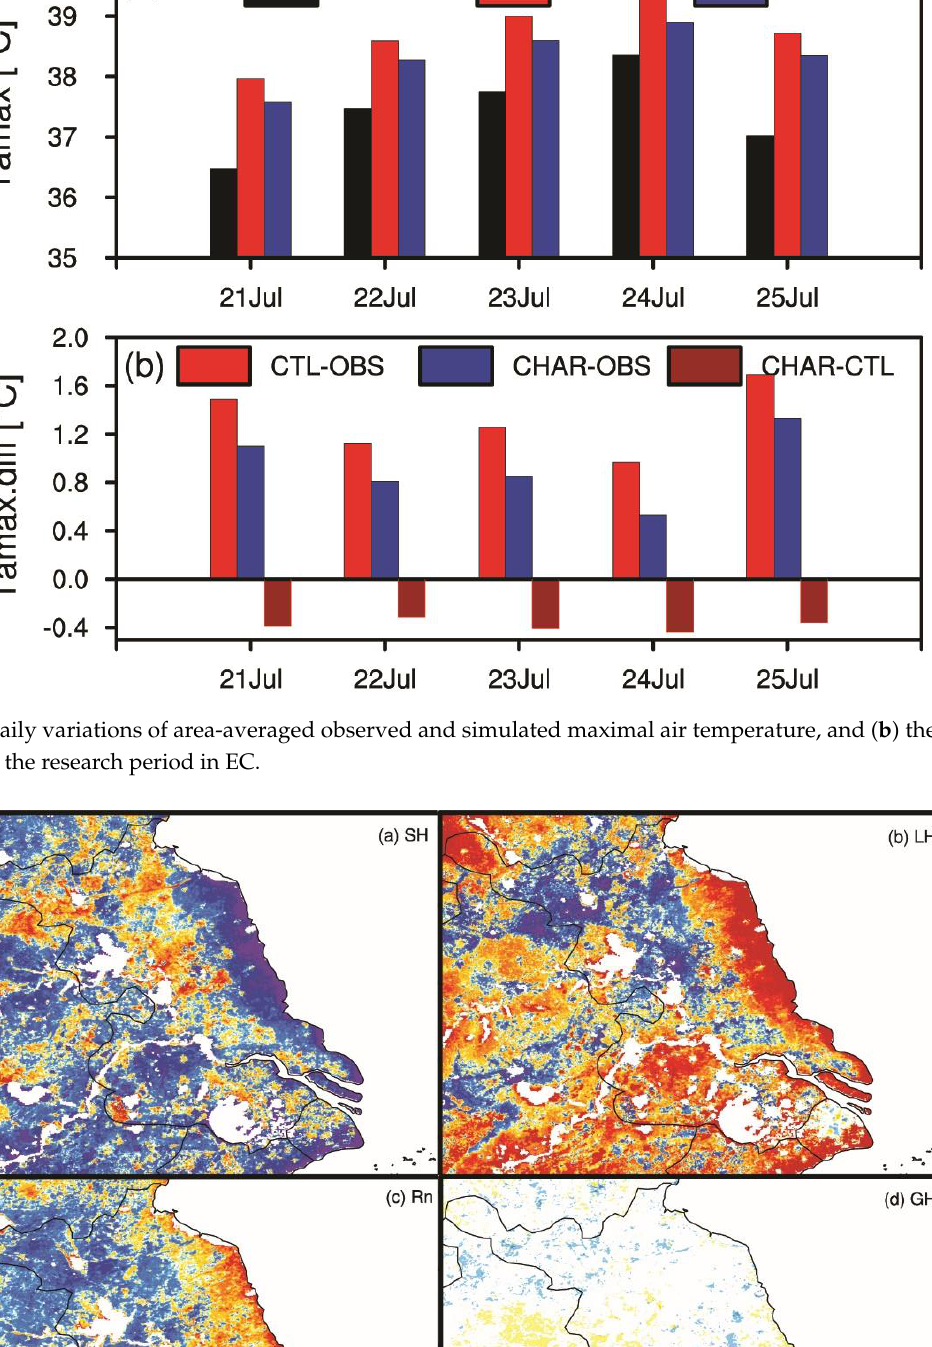
Figure 8. Spatial distribution of mean maximal air temperature (unit: °C) for ( a ) CTL experiment, ( b ) CHAR experiment, and ( c ) their difference over the research period in EC.